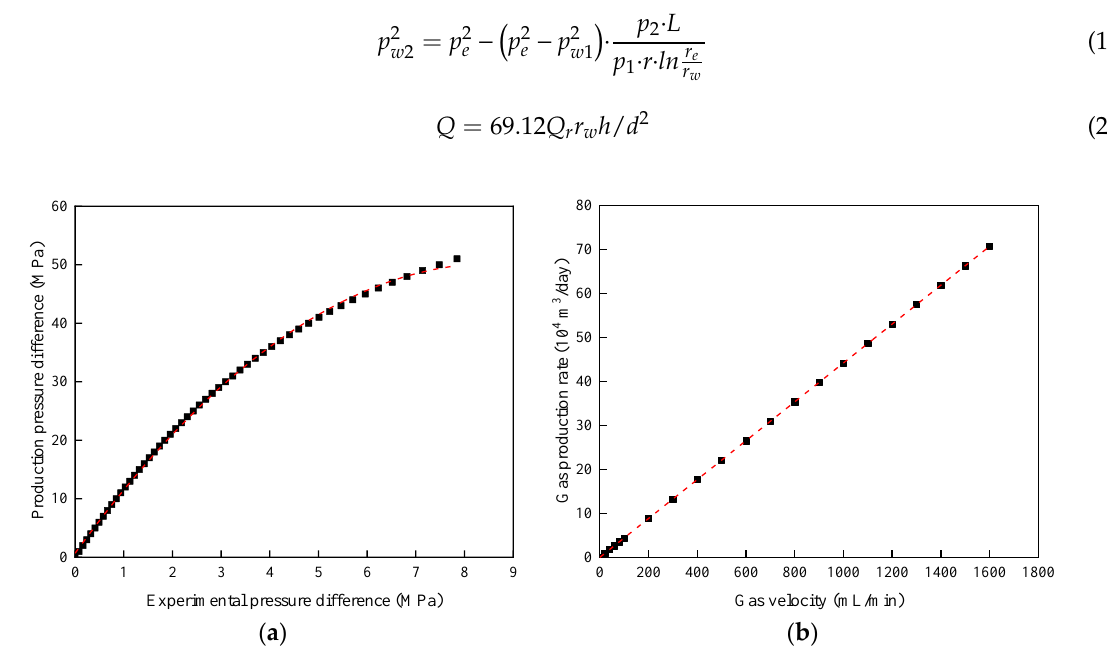
Figure 4. Similarity transformation results: ( a ) experimental pressure difference vs. production pressure difference; ( b ) gas velocity vs. gas production rate.